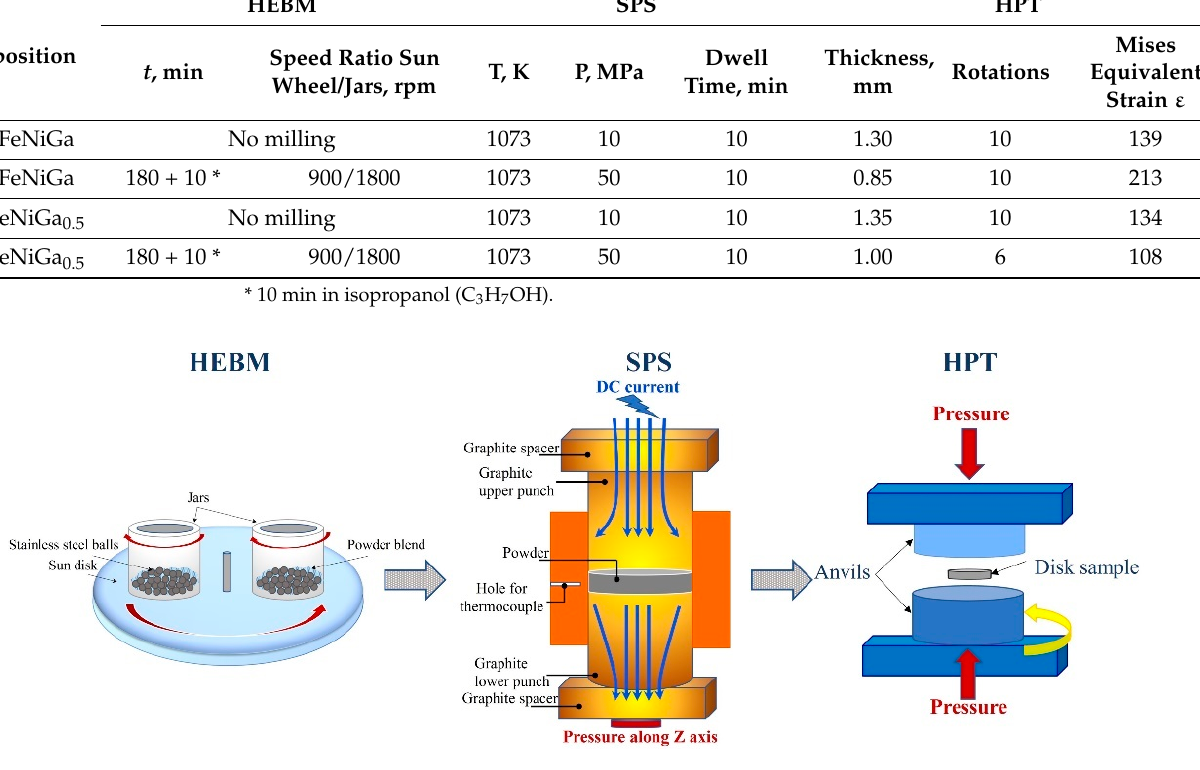
Figure 1. A schematic diagram of the combined use of HEBM, SPS and HPT processes for the synthesis of nanocrystalline bulk HEAs.